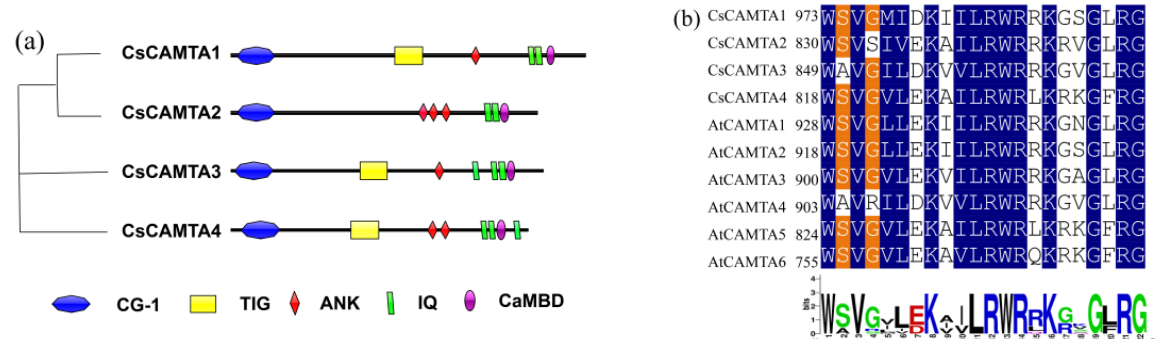
Figure 2. Protein conserved domain of the CsCAMTAs ( a ): Schematic diagram of all domains ( b ): Alignment of conserved CaMBD of CsCAMTAs with 6 AtCAMTAs . The full name of the abbreviation: CG-1, sequence-specific DNA-binding domain; TIG, transcription-associated immunoglobulin-like domain; ANK, ankyrin repeat domain; IQ, isoleucine glutamine motif; CaMBD, calmodulin-binding domain.